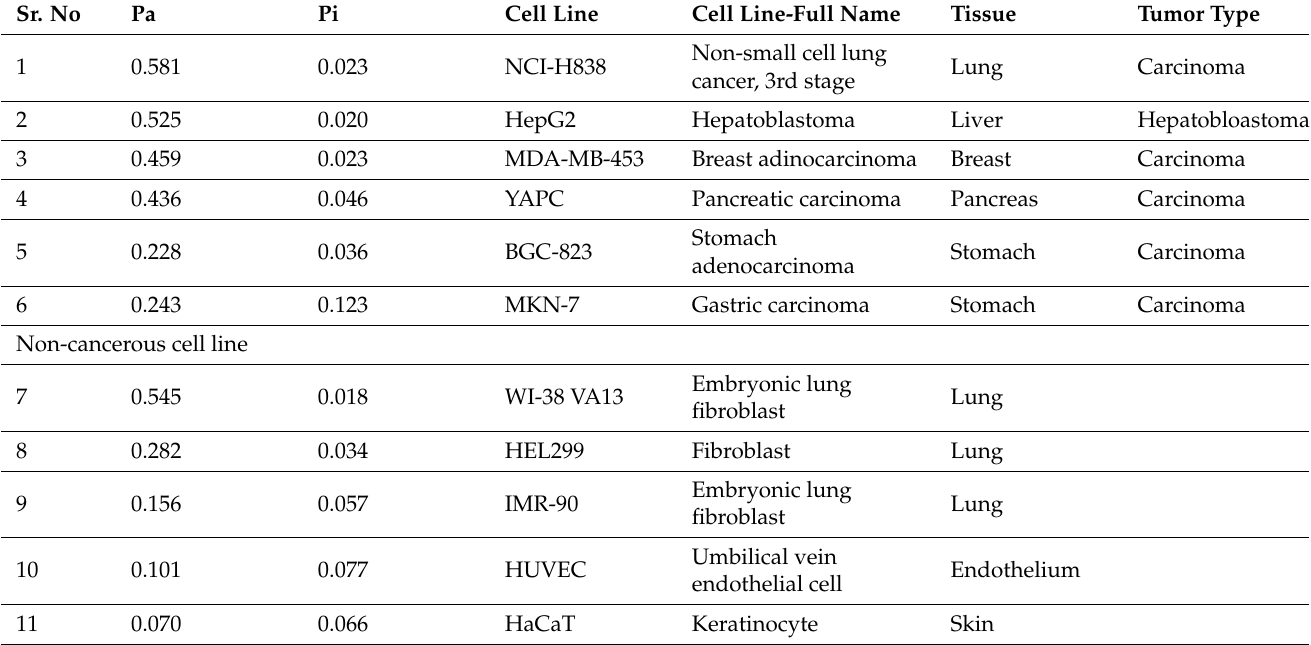
Table 5. CLC-Pred analysis of chlorogenic acid cancerous cell line and non-cancerous cell line prediction.